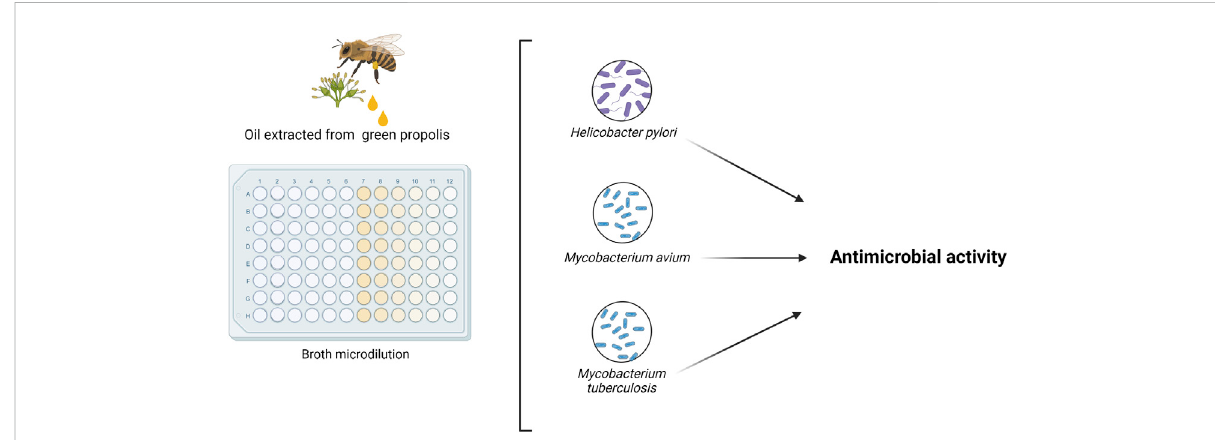
FIGURE 11 Antimicrobial activity of the oil extracted from B. dracunculifolia green propolis (Quintino et al.,